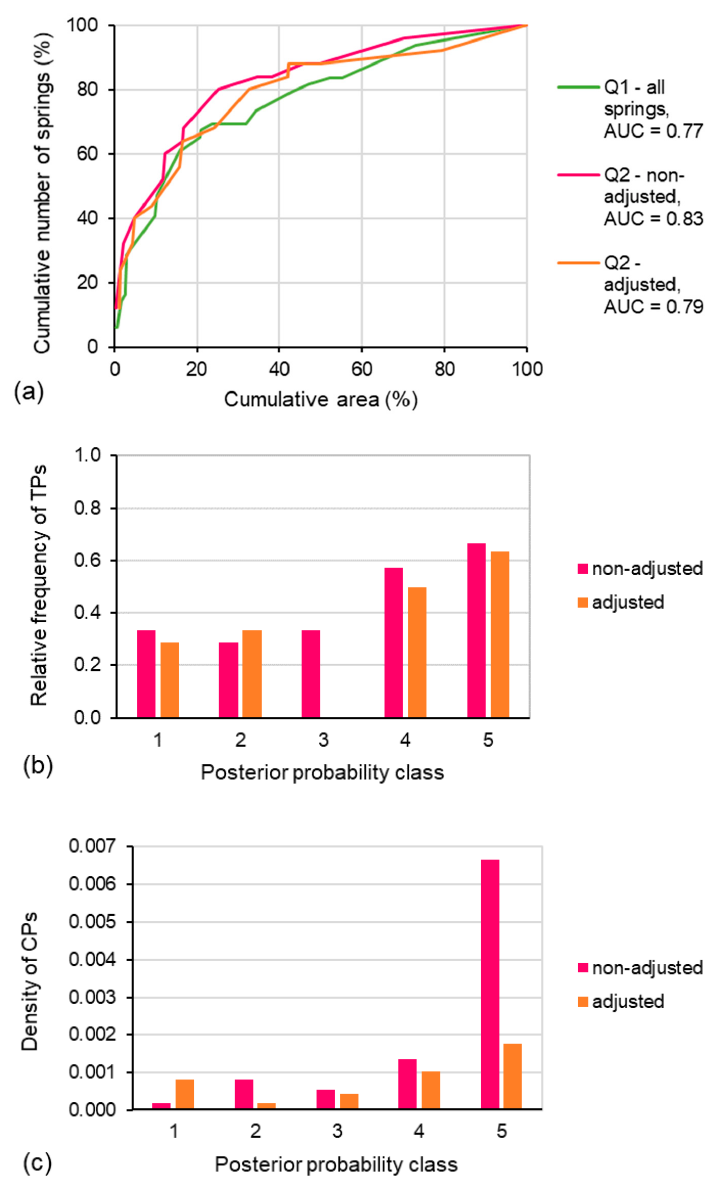
Figure 9. Validation procedures: ( a ) Area Under the Curve (AUC) curves, ( b ) frequency histograms and ( c ) density histograms.